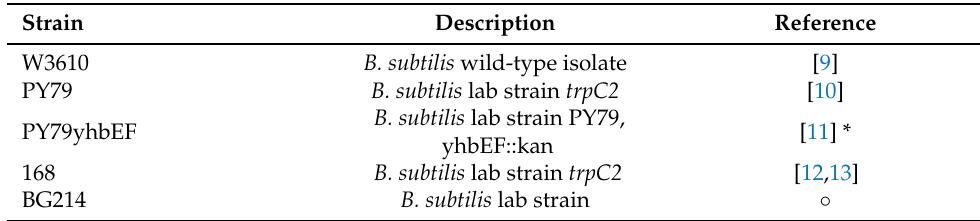
Table 1. List of strains used in the study. * = flagella deficient. ◦ = Strain from the laboratory of Juan